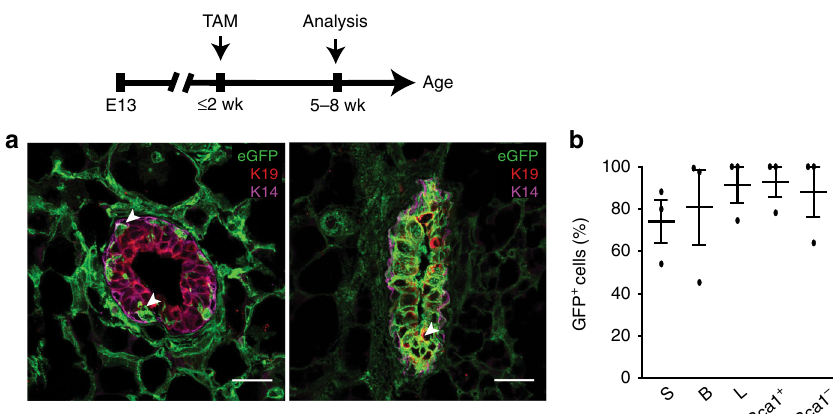
Fig. 5 PDGFR α + cell descendents contribute to early mammary epithelial development. a Immuno fl uorescent images of GFP-labeled cells with epithelial Keratins (luminal-K19, basal-K14) in 5 – 8 week old mammary tissue following TAM induction in prepubescent mice (representative of intermediate (left) and high (right) GFP labeling within the epithelium); n = 3 mice; scale bar = 25 µ m. b GFP + cells in stromal (S), basal (B), luminal (L), and luminal Sca1 + , Sca1 - mammary subsets ( n = 3 mice). Data represent mean ± s.e.m. Source data are available as a Source Data fi